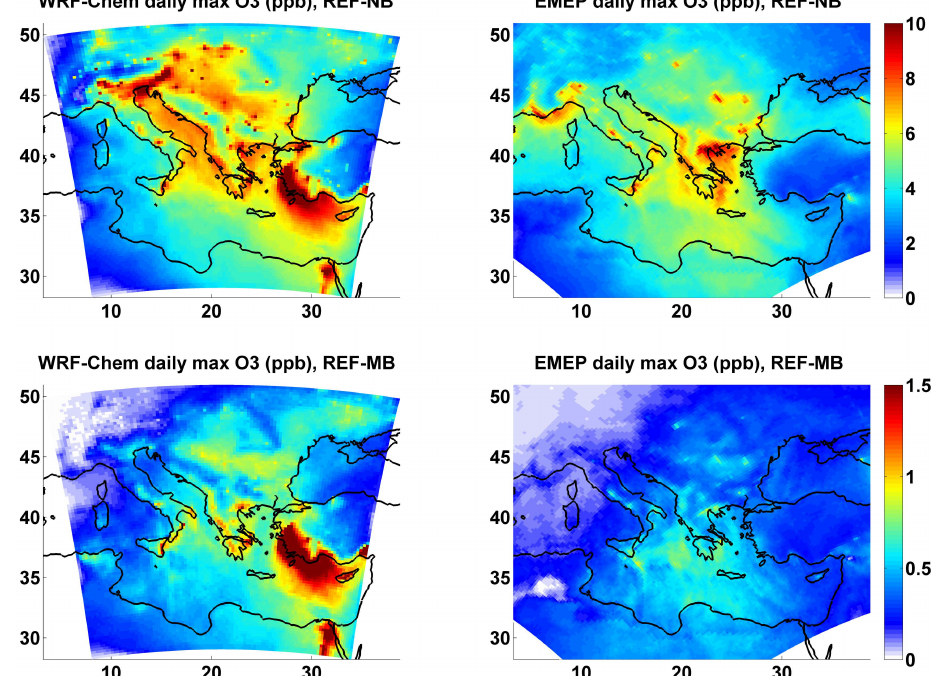
Fig. 12. Change in daily maximum near-surface ozone (ppbv) due to biogenic emissions (REF-NB) (top) and due to high temperatures (above 28 ◦ C) in the computation of biogenic emissions (REF-MB) (bottom), calculated by WRF-Chem (left) and EMEP MSC-W (right) averaged over the summer (JJA)